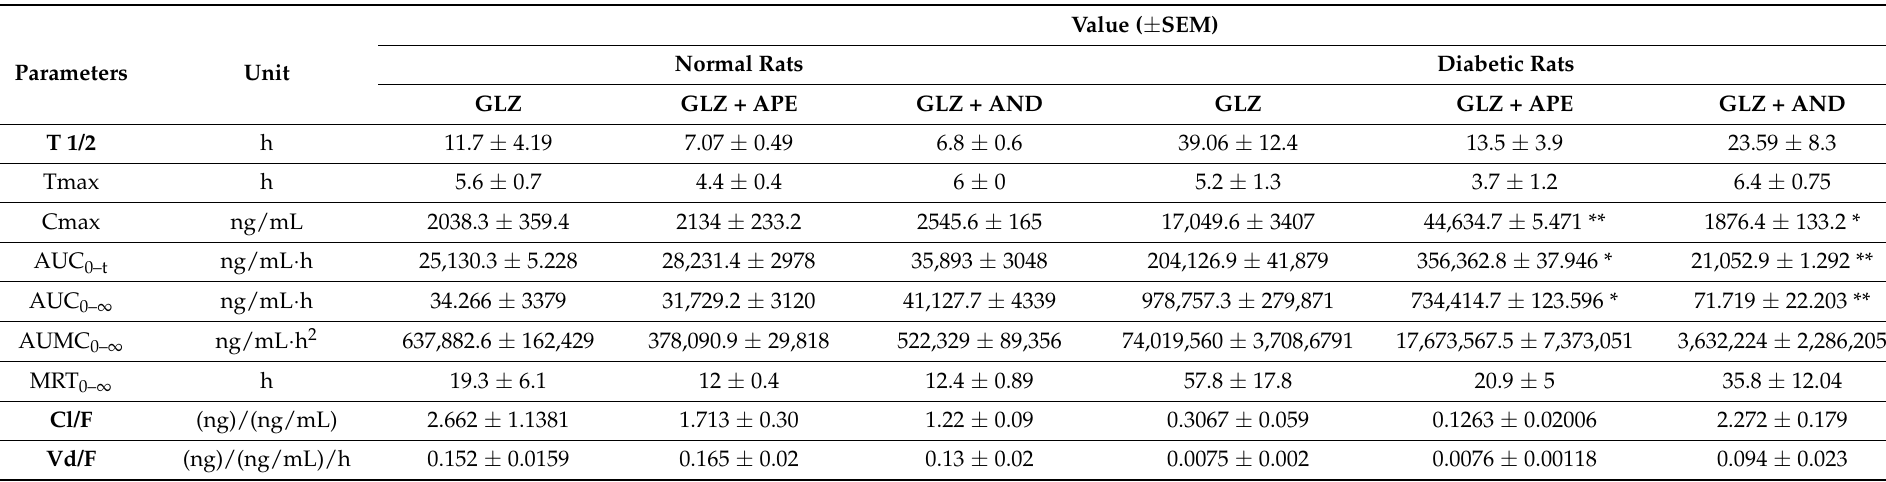
Table 6. Pharmacokinetic parameters of glipizide in the plasma of normal and diabetic